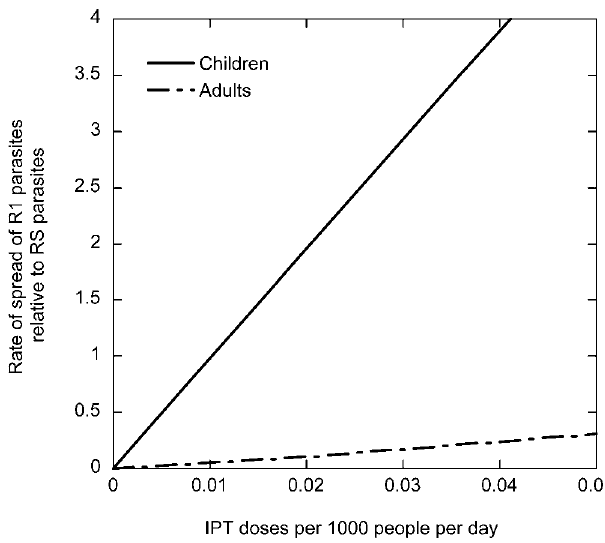
Figure 7. Effect of IPT in Adults or Infants on the Percent Increase of R1 Relative to RS Parasites Doses of drug administered to nonimmune infants have a greater impact on the spread of partial resistance. DOI: